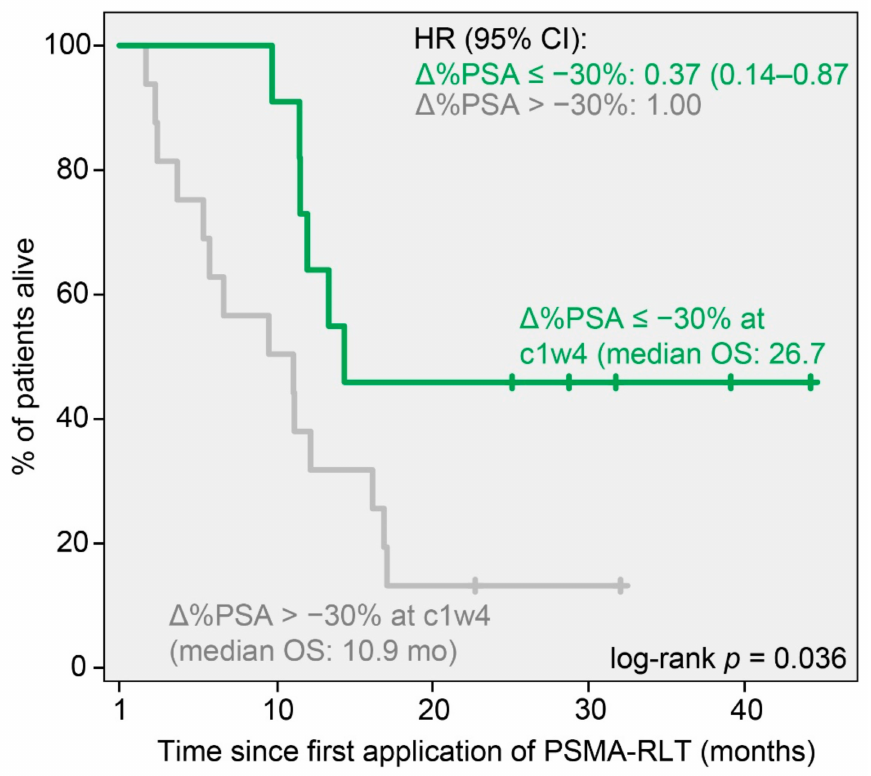
Figure 5. Kaplan–Meier curves for the OS of patients stratified by a PSA decrease of at least 30% ( ∆ %PSA ≤ − 30%) at four weeks (c1w4). Median OS and hazard ratios (HR) with 95% confidence interval (95% CI) are given for each